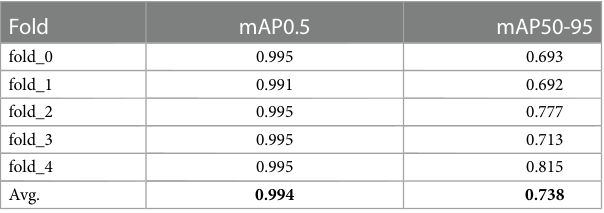
TABLE 1 YOLOv5l prediction mAP (mean average precision) for each